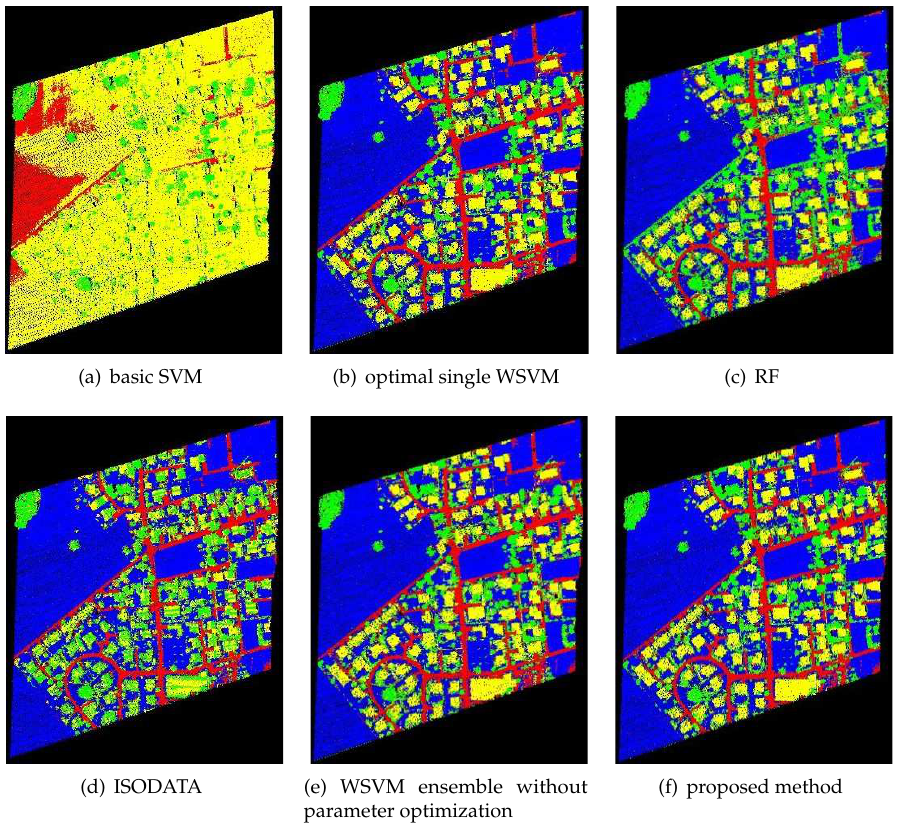
Figure 4. Classification results of Study Area 2.